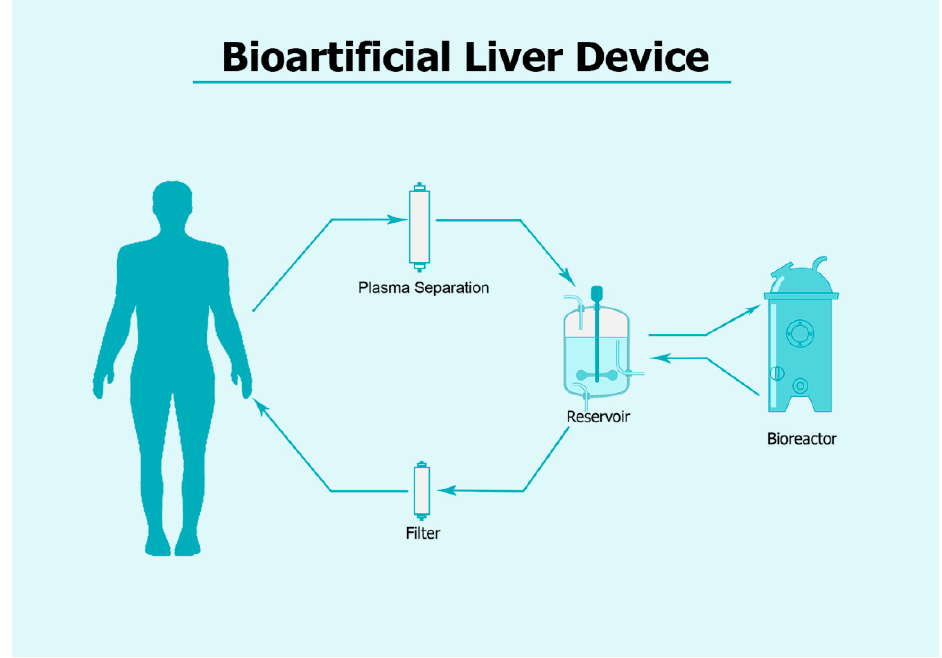
Figure 3. A Bioartificial Liver (BAL) system: Patient blood is taken from the venous circulation and separated from plasma, which flows into a reservoir through a pump system. The plasma then goes into a bioreactor inoculated with living cells and returns to the patient after filtration and rejoins the